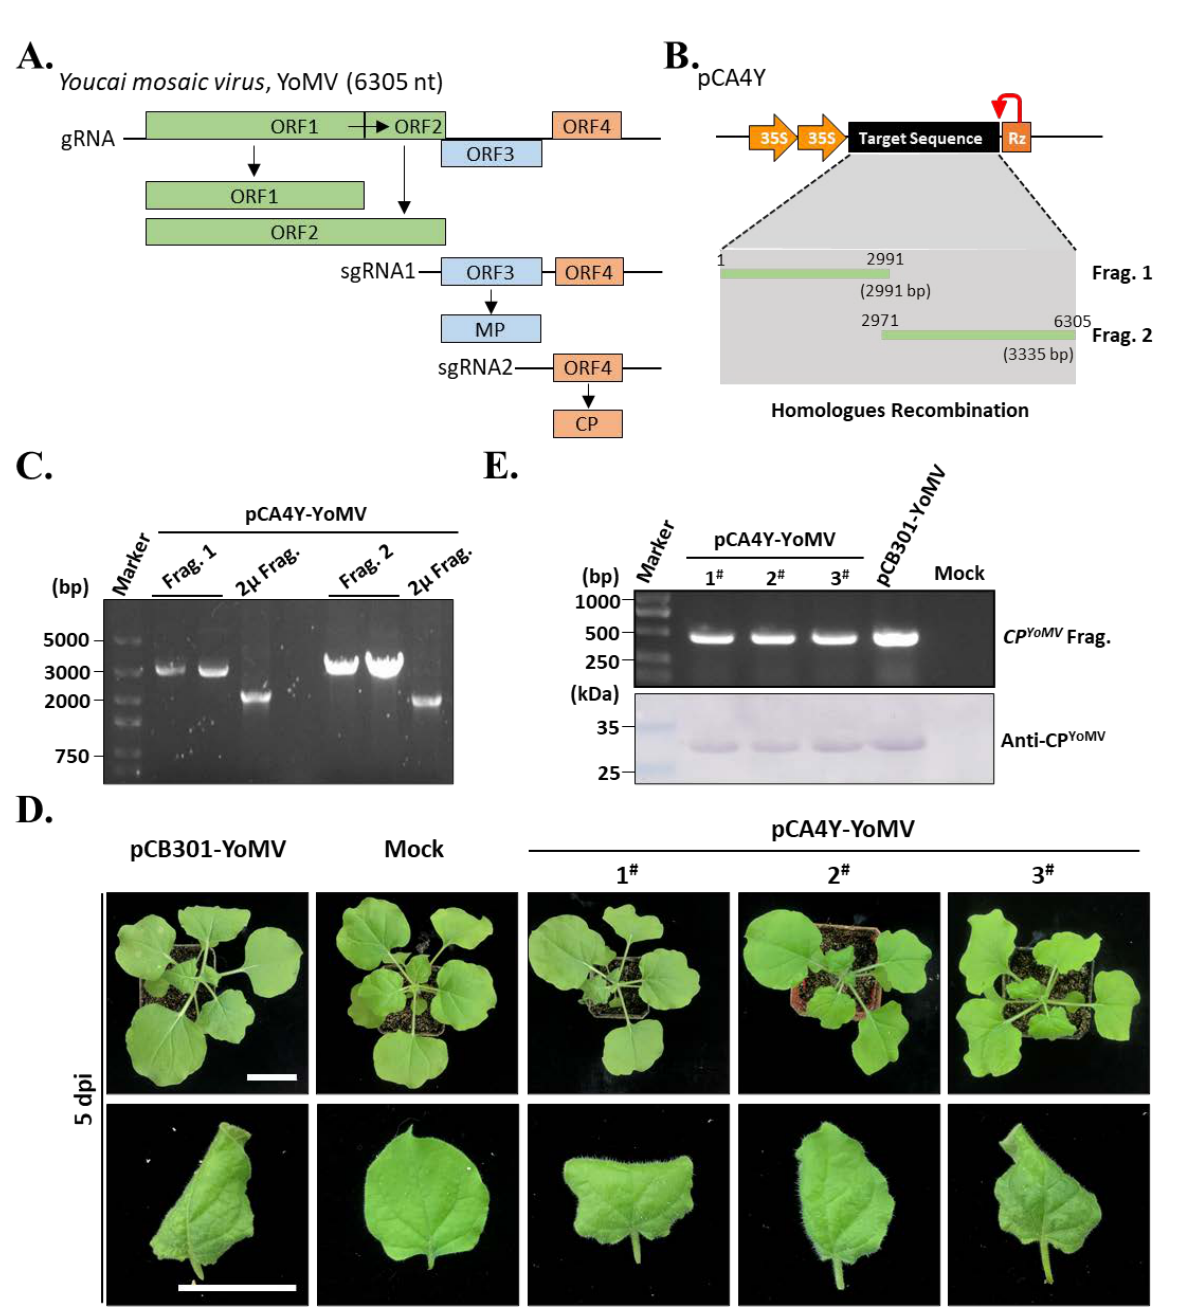
Figure 4. Construction of the Youcai mosaic virus (YoMV) infectious cDNA clone using the established triple-shutting vector-based yeast HR recombination. ( A ). Genome organization of the YoMV. Similarly, the ORF1 and ORF2 served as the viral replicase. The sub-genomic RNA1 and RNA2 encode the MP and CP. ( B ). Illustration of the detailed construction strategies for the YoMV single cDNA. The cDNA was divided into two parts: one is 2991 bp (Frag. 1), and another one is 3335 bp (Frag. 2). ( C ). PCR validation of the positive YoMV infectious cDNA clone with specific pairs of primers listed in Supplementary Table S1. The detailed meaning of the Frag. 1 and Frag. 2 were shown in ( B ). ( D ). Symptoms of the YoMV infectious cDNA clones-inoculated N. benthamiana plants after 5 dpi. The pCB301-YoMV-inoculated plants were treated as positive control. The mock, and numbers shown were the same meaning in Figure 3D. Bar indicates 3 cm. ( E ). RT-PCR and Western blot detect the infectivity of the newly constructed YoMV infectious clones. Specific pairs of primers and antibodies for the CP coding gene and protein were used in the assays, respectively.